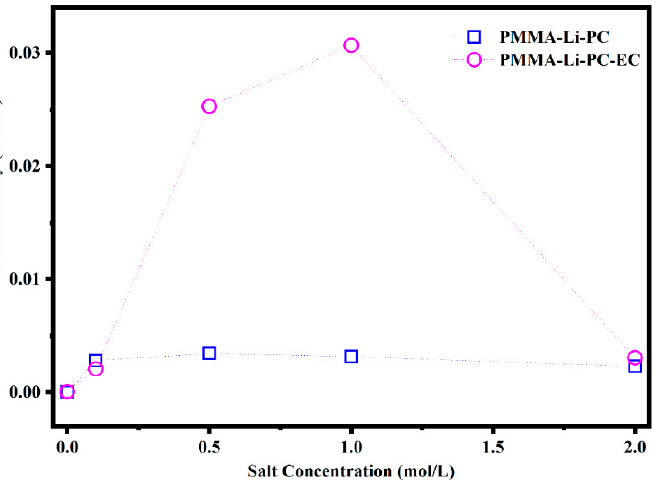
Figure 2. Trend of the ionic conductivities as a function of the salt concentration obtained on polymeric gel electrolyte.